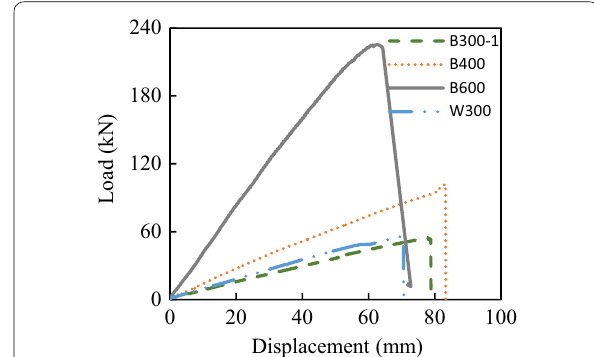
Fig. 5 Load–displacement curves of bending test on the mid-span of different I-beams